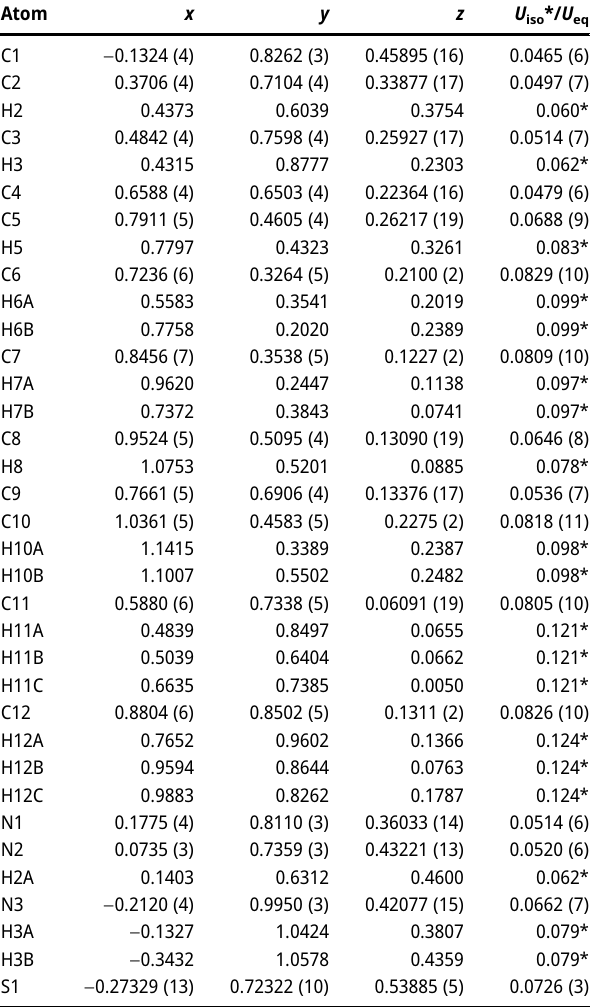
Table  : Fractional atomic coordinates and isotropic or equivalent isotropic displacement parameters (Å 